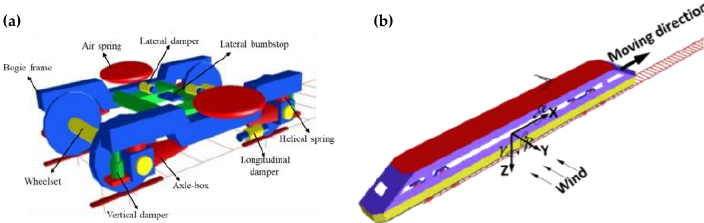
13 of 17 Figure 16. Flow field distribution at t * = 94: ( a ) vortex around the train ( Q = 5000) and ( b ) velocity distribution at a height of 0.5 h. Figure 17. Top view of streamlines at a height of 0.5 h. 3.3. Analysis of Vehicle System Dynamic (VSD) Responses To understand the dynamic characteristics when of train running in the WT region,